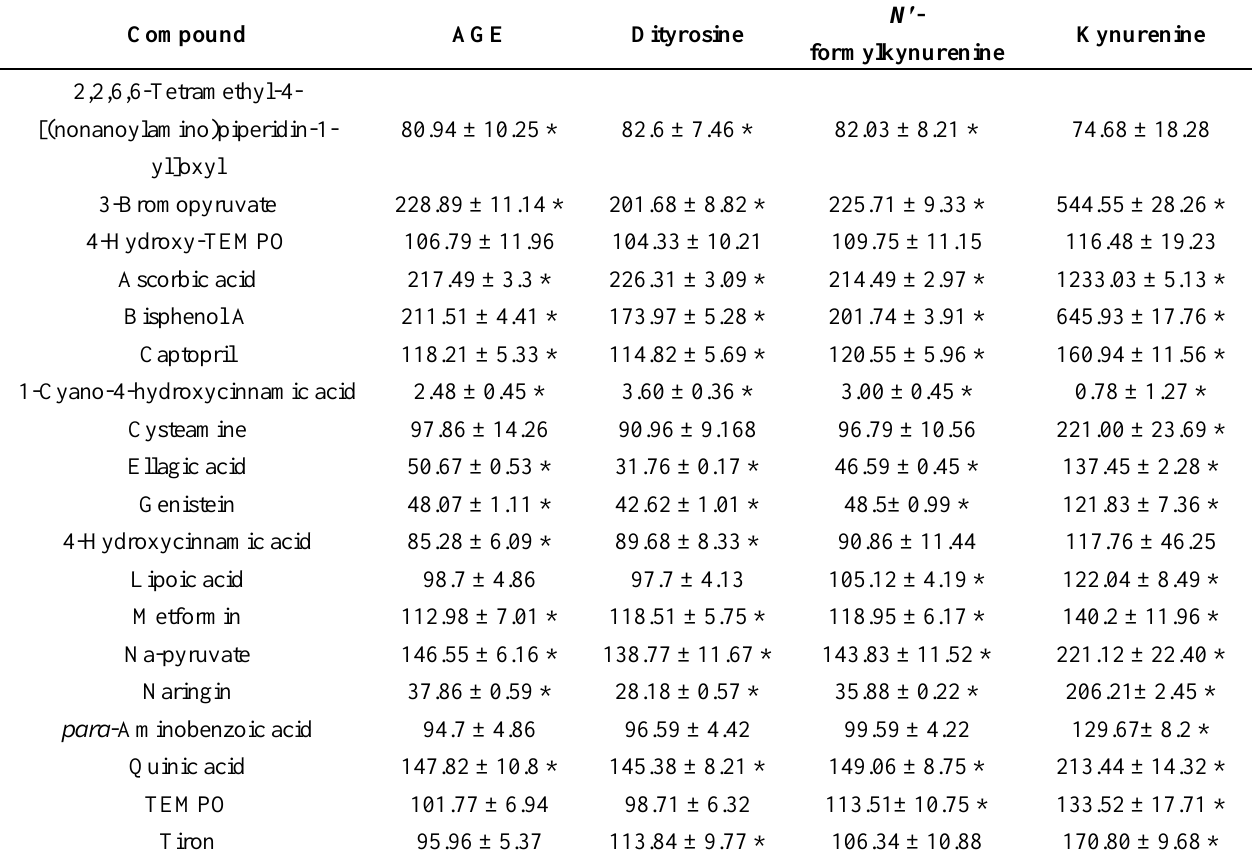
Table 3. Inhibition by various compounds of AGE, dityrosine, N’-formylkynurenine and kynurenine in BSA induced by glyoxal (GO). Values expressed as % of fluorescence increase in samples incubated without any additives (with DMSO only for compounds introduced as solutions in DMSO), given as mean values ± SD from 6 independent experiments. * p < 0.05 or